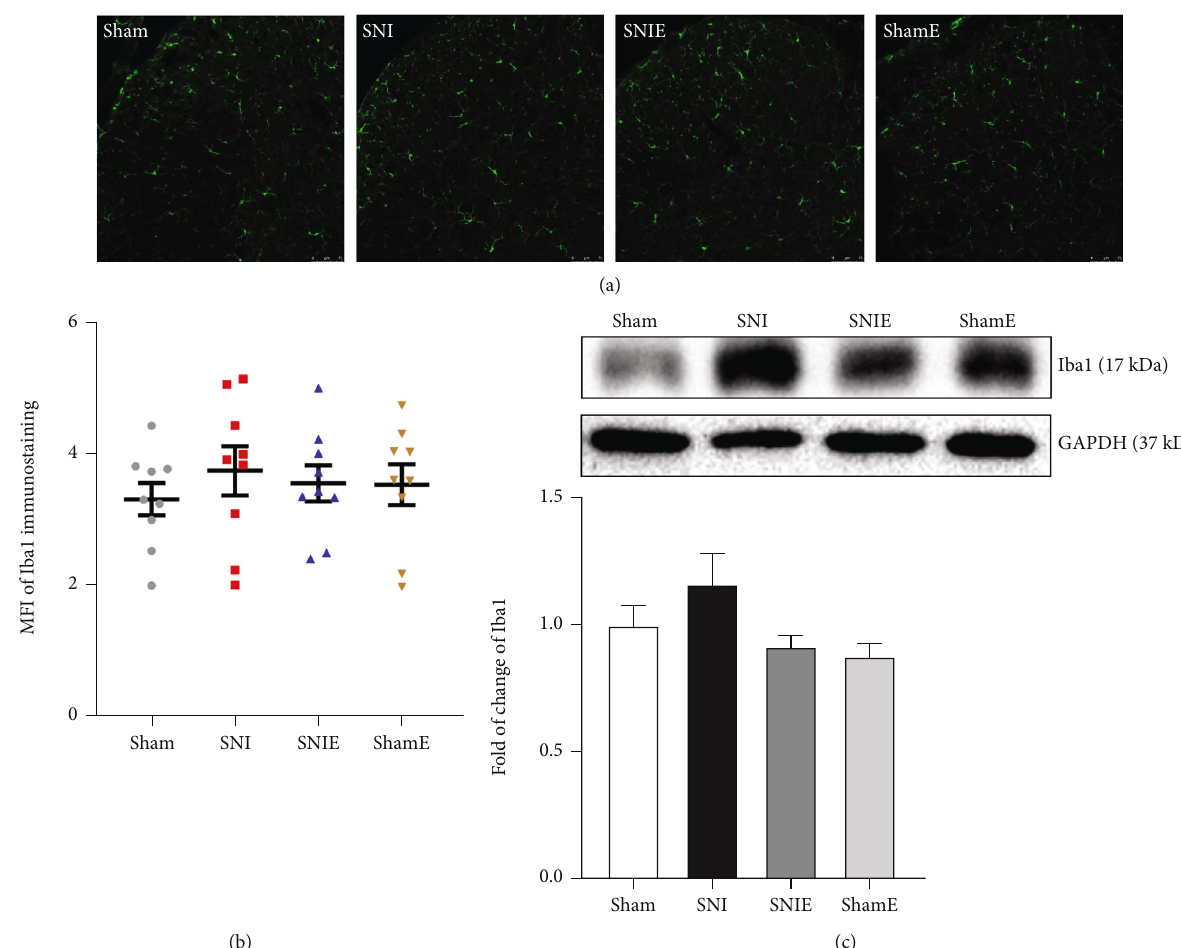
Figure 5: Microglia in the spinal cord are not activated in mice 24 days after SNI. (a) Representative images of MFI for Iba1 in the spinal dorsal horn. (b) Quanti fi cation of Iba1 in the spinal dorsal horn. Values represent the mean ± SEM ( scalebar = 75 μ m, n = 9 spinal slices from three mice for each group). (c) Western blotting analysis of the expression changes of Iba1 ( n = 6 ). Values represent the mean ± SEM